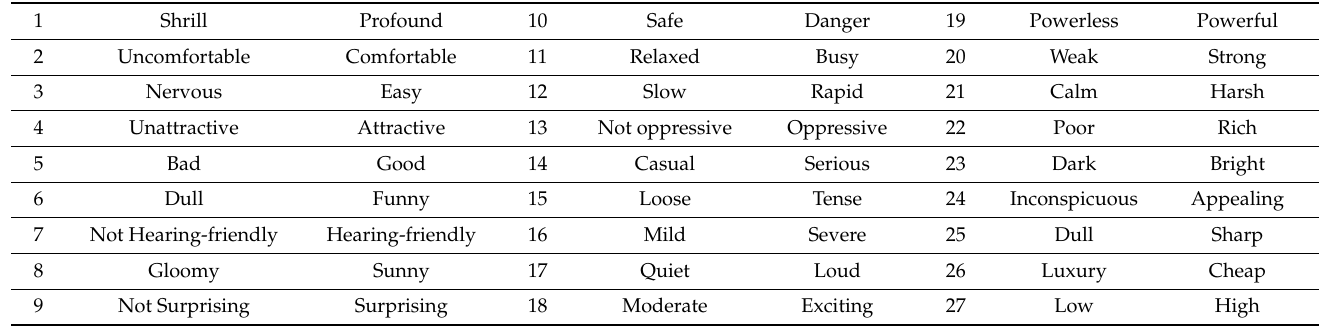
Table 3. List of the 27 pairs of adopted